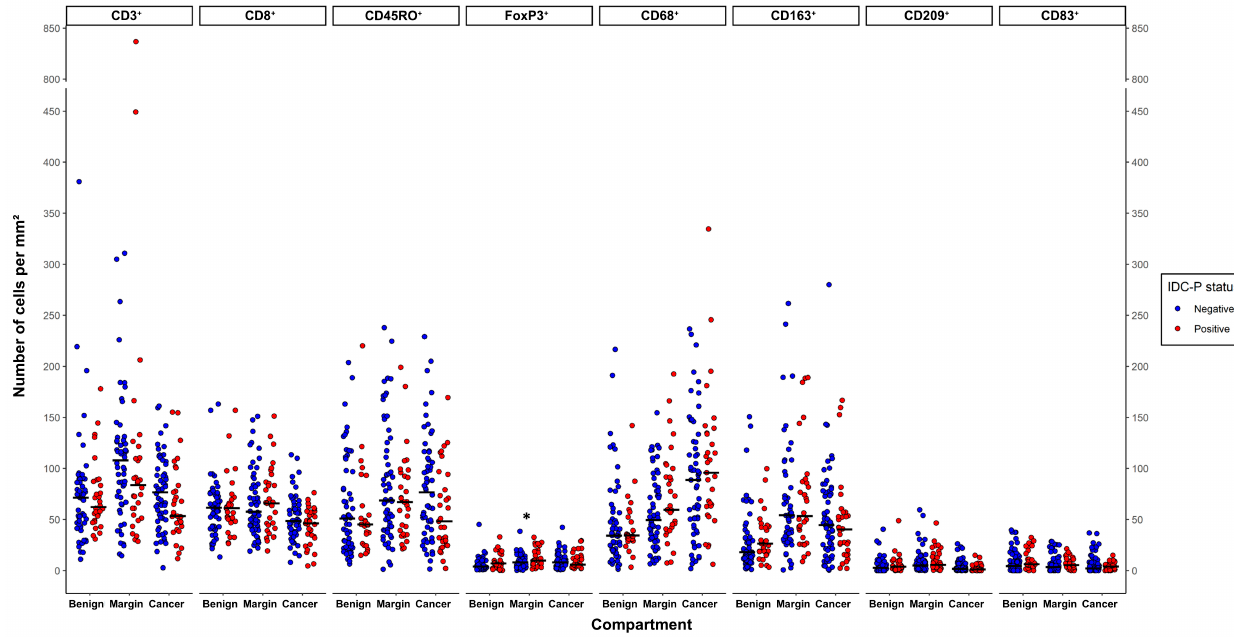
Figure 2. Leucocyte densities depending on IDC-P status. Dots represent individual patients. Horizontal bars represent medians. For each compartment, mean ranks according to IDC-P status were compared using the Mann–Whitney U test. * p = 0.016.